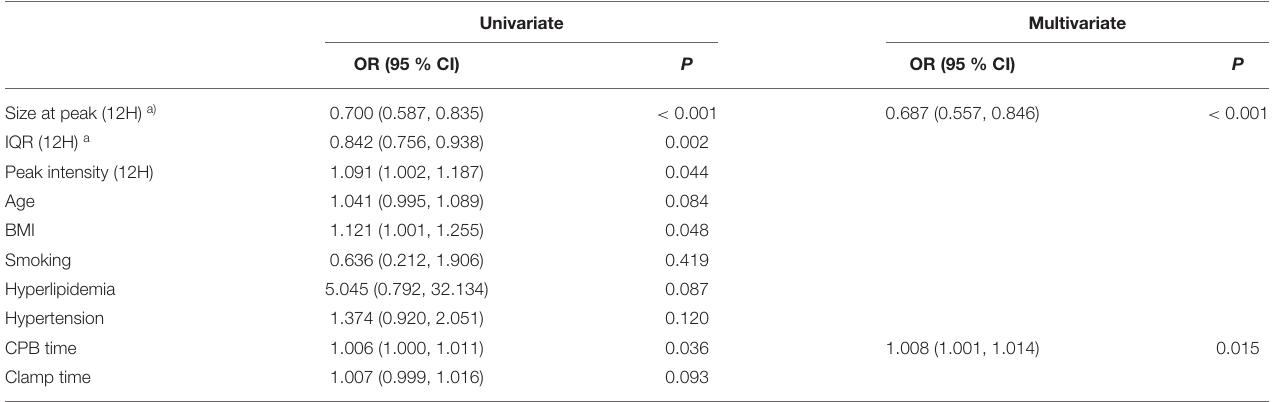
TABLE 5 | Univariate and multivariate analyses of ALI. Univariate Multivariate